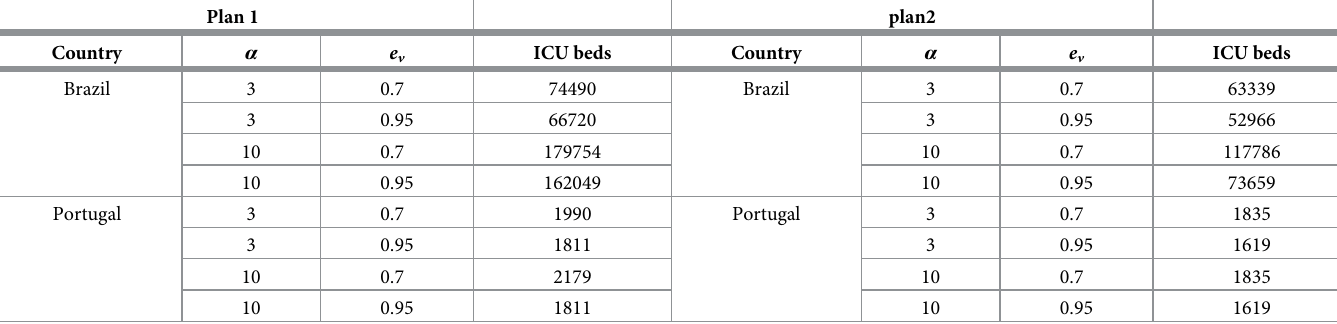
Table 2. Estimated demand of ICU beds for each vaccination plan and limit contact factors α = 3 and α =